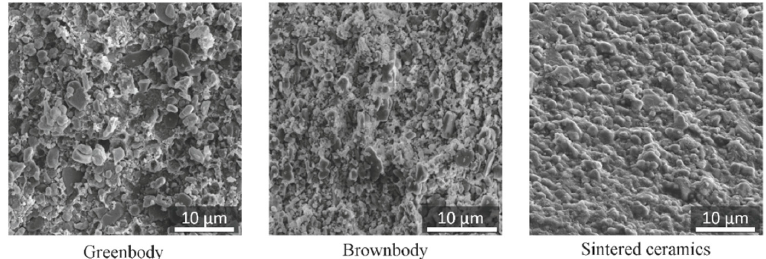
Figure 5. Scanning electron microscopy (SEM) images of Al 2 O 3 ceramic samples, manufactured and processed with stereolithography-based additive technology.